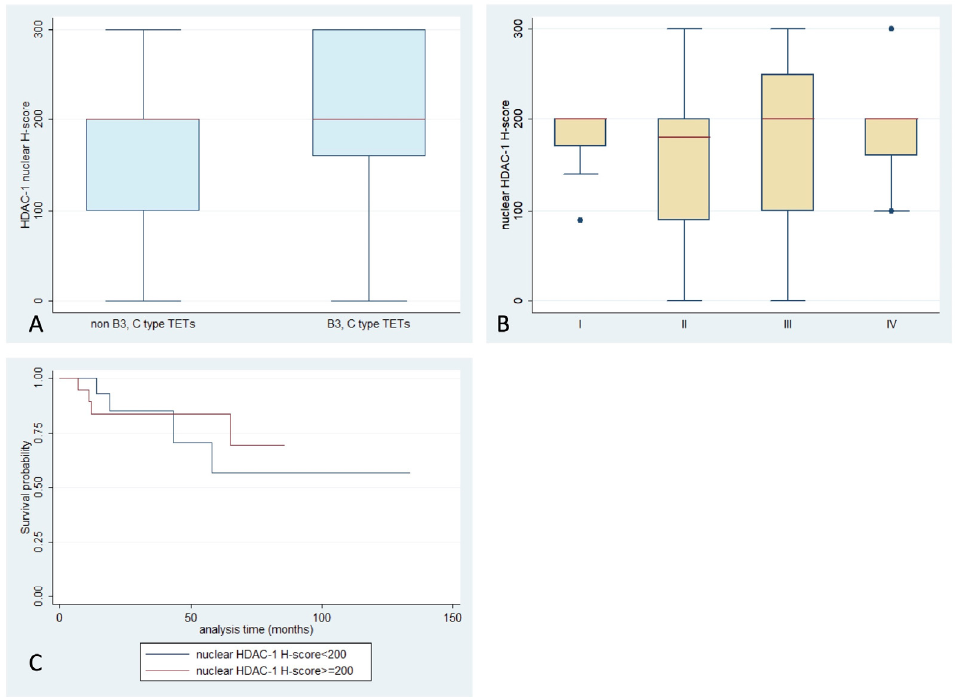
Figure 2. Schematic representation of the associations between nuclear HDAC1 H-score and ( A ) WHO histological type, ( B ) Masaoka–Koga stage, and ( C ) patients’ overall survival. Table 2. Expression of HDAC1, -2, -3, -4, -5, and -6 in the epithelial component of TETs.